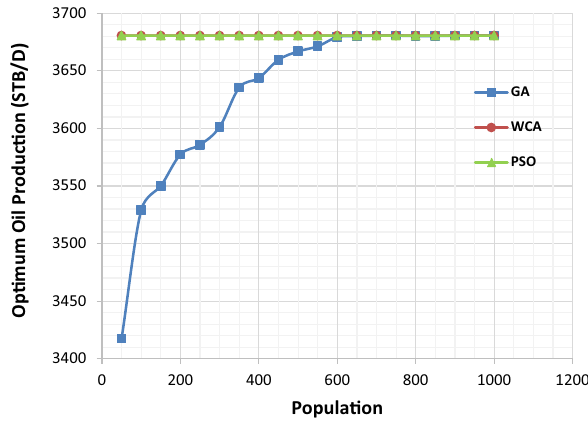
Fig. 6 Optimization CPU run time at different populations for WCA, PSO and GA